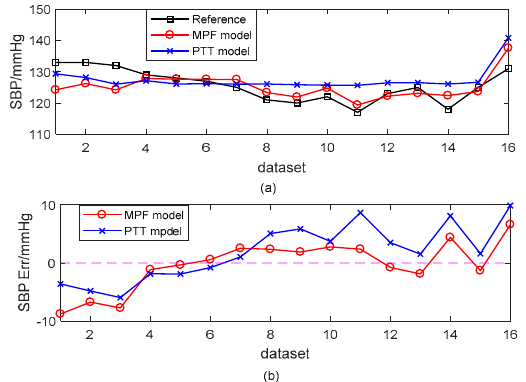
Figure 8. An example of the estimated SBP with the MPF model and the PTT-based model with the cuff-based BP as a reference. ( a ) Dataset SBP. ( b ) SBP errors.